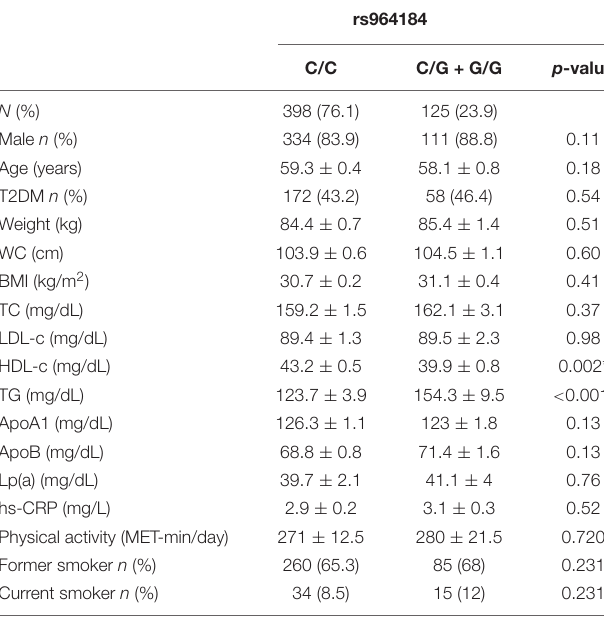
TABLE 1 | Baseline characteristics by genotype according to ZPR1 SNP rs964184.